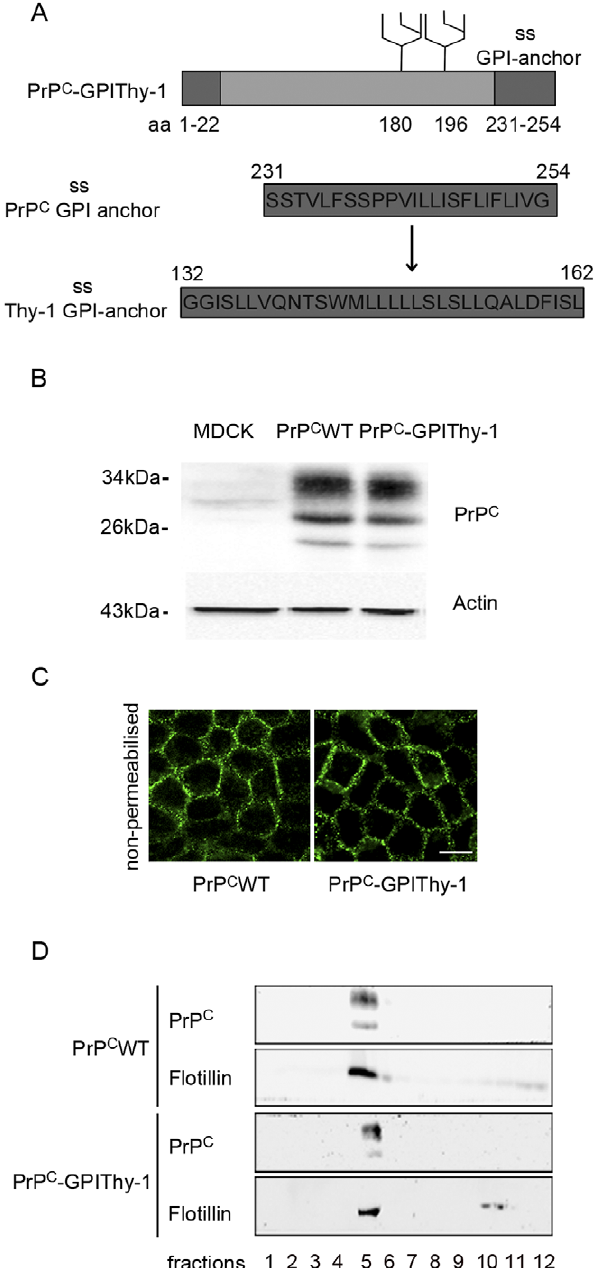
Figure 5. PrP C -GPIThy-1 is glycosylated and transported to the plasma membrane. (A) Schematic presentation of GPI-anchored PrP C WT and the PrP C fusion protein with the GPI-anchor of Thy-1 (PrP C -GPIThy-1). The substitution of the GPI-anchor signal sequence (ss) of the PrP for the one of Thy-1 is indicated. (B) Western blots of PrP C WT and PrP C -GPIThy-1 stably expressed in MDCK cells. A clone with a similar expression level as PrP C WT was chosen. The glycotype of di-, mono-, and non-glycosylated PrP C -GPIThy-1 is unchanged. (C) Assessment of non-permeabilized membrane localization of PrP C WT and PrP C -GPIThy-1 by confocal microscopy shows plasma membrane localization of both proteins (scale bar is 10 m m). (D) Sucrose density gradient centrifugation of 1% Triton-X100 extraction at 4 u C of PrP C WT and PrP C -GPIThy-1 cells reveal localization of both in flotillin enriched DRMs. Fractions were taken from the top (fraction 1) to the bottom (fraction 12).